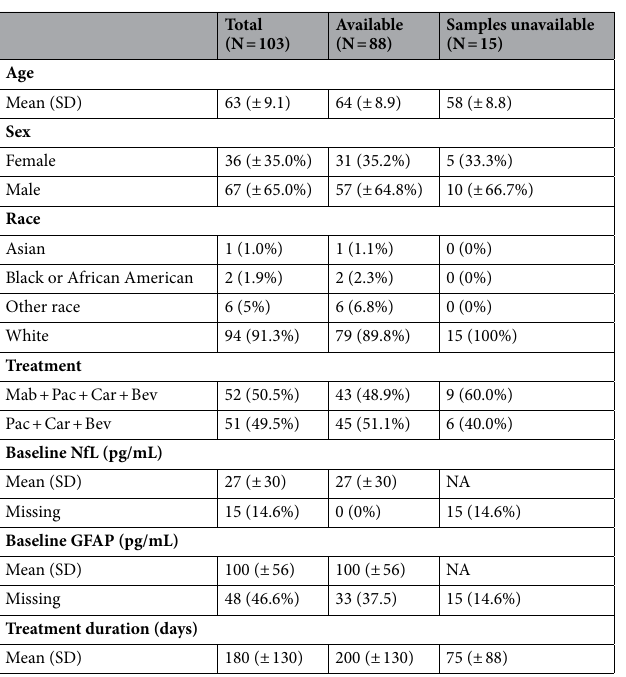
Table 1. Subject Demographics. Demographics and baseline biomarker levels for all enrolled subjects and subjects included in biomarker analysis. MAb: Experimental monoclonal antibody; Pac: Paclitaxel, Car: Carboplatin, Bev: Bevacizumab, NA: Not